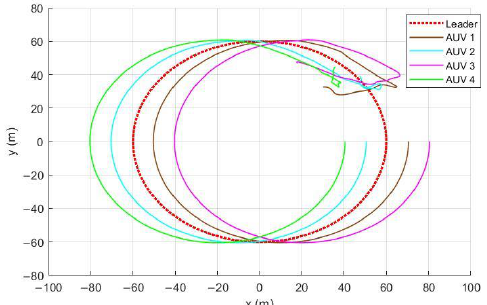
Figure 5. AUV formation-level simulation diagram.